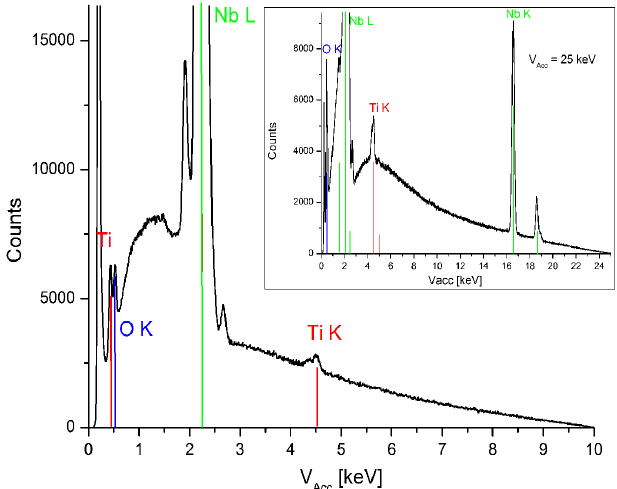
FIG. 20. Electron dispersive x-ray spectrum of sample L50 at 10 keV (main figure) and 25 keV (inset) show the presence of titanium (red lines) and oxygen (blue lines) on the surface of the niobium (green lines). The filament current was 10 (cid:1) A , the magnification was 5000 and the aperture was 100 (cid:1) m .